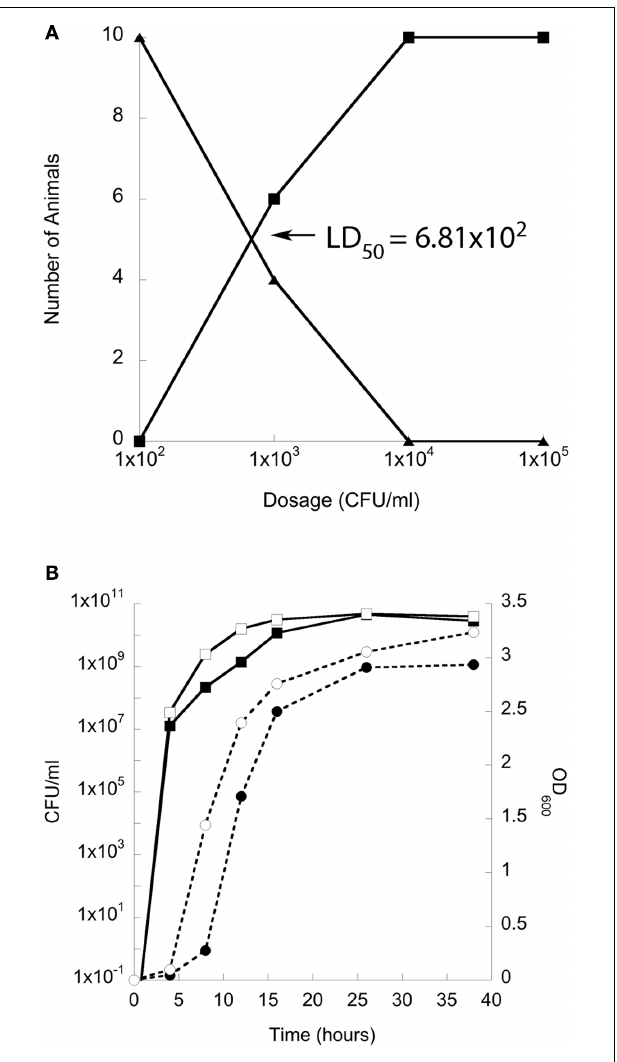
FIGURE 2 | CSM001 comparison to B. malleiATCC 23344. (A) The 10-day LD 50 for CSM001 was determined by infecting groups of 10 animals by i.n. with the indicated doses and monitoring the death (squares) and survival (triangles) of the animals. (B) Cultures of CSM001 (open symbols) and B. mallei ATCC 23344 (closed symbols) were grown to mid log phase ( ∼ 12h) while shaking at 37˚C.The cultures were diluted 1:100 and monitored by OD 600 (circles) and CFU plating (squares) for 38h at approximately 4h intervals. Individual data points represent the CFU mean ± SEM of three independent experiments. *, P <